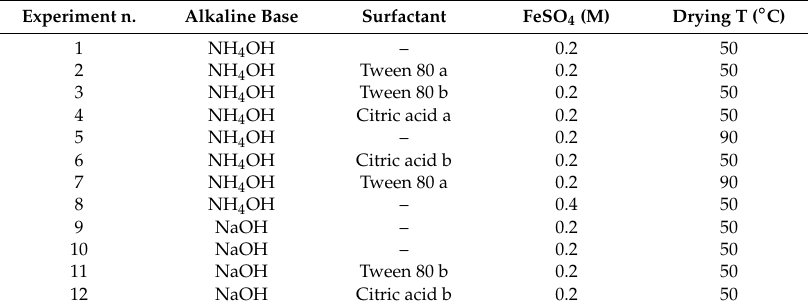
Figure 1. Reaction stage of the particle production process. Table 1. Experiments and the values of the operational variables.